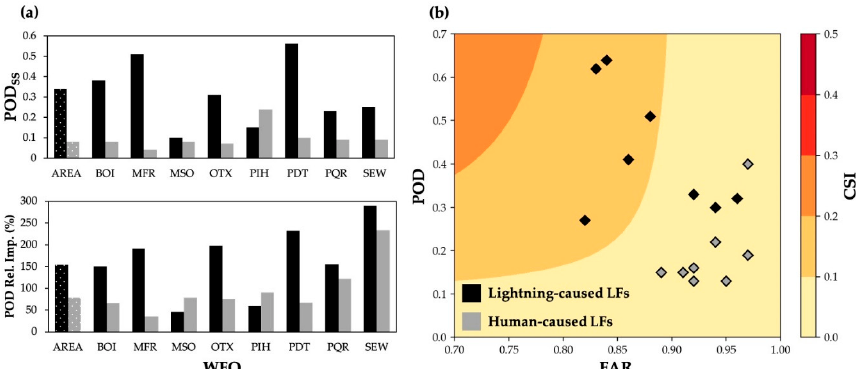
Figure 5. POD skill scores and relative improvement ( a ) and performance metrics ( b ) of RFWs for lightning- and human-caused large fire days across the WFOs. For ( b ), critical success index (CSI) is found to generally increase with higher POD and decreasing false alarm ratio